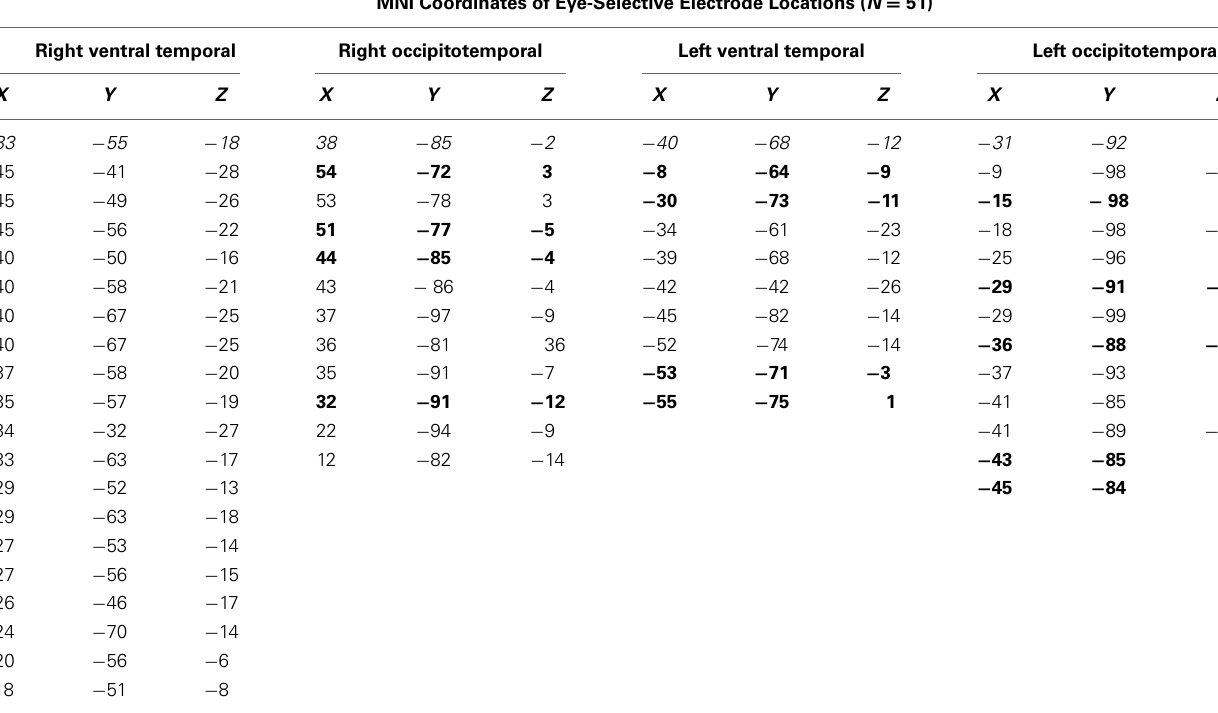
Table 2 | Electrode locations of eye-selective sites within each spatial cluster. MNI Coordinates of Eye-Selective Electrode Locations ( N = 51) Right ventral temporal Right occipitotemporal Left ventral temporal Left